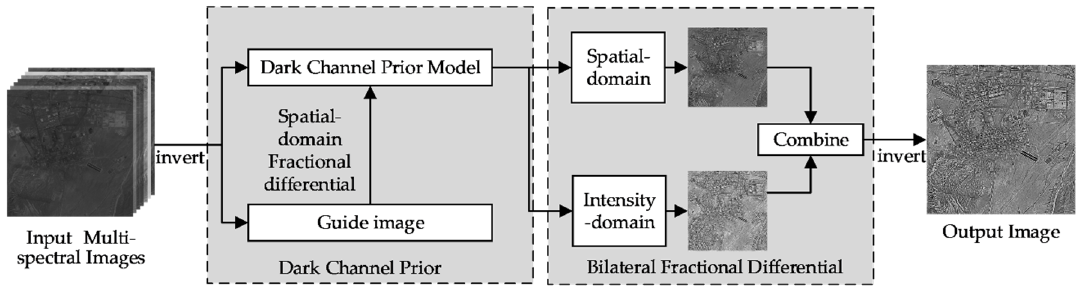
Figure 1. Algorithm flow chart.